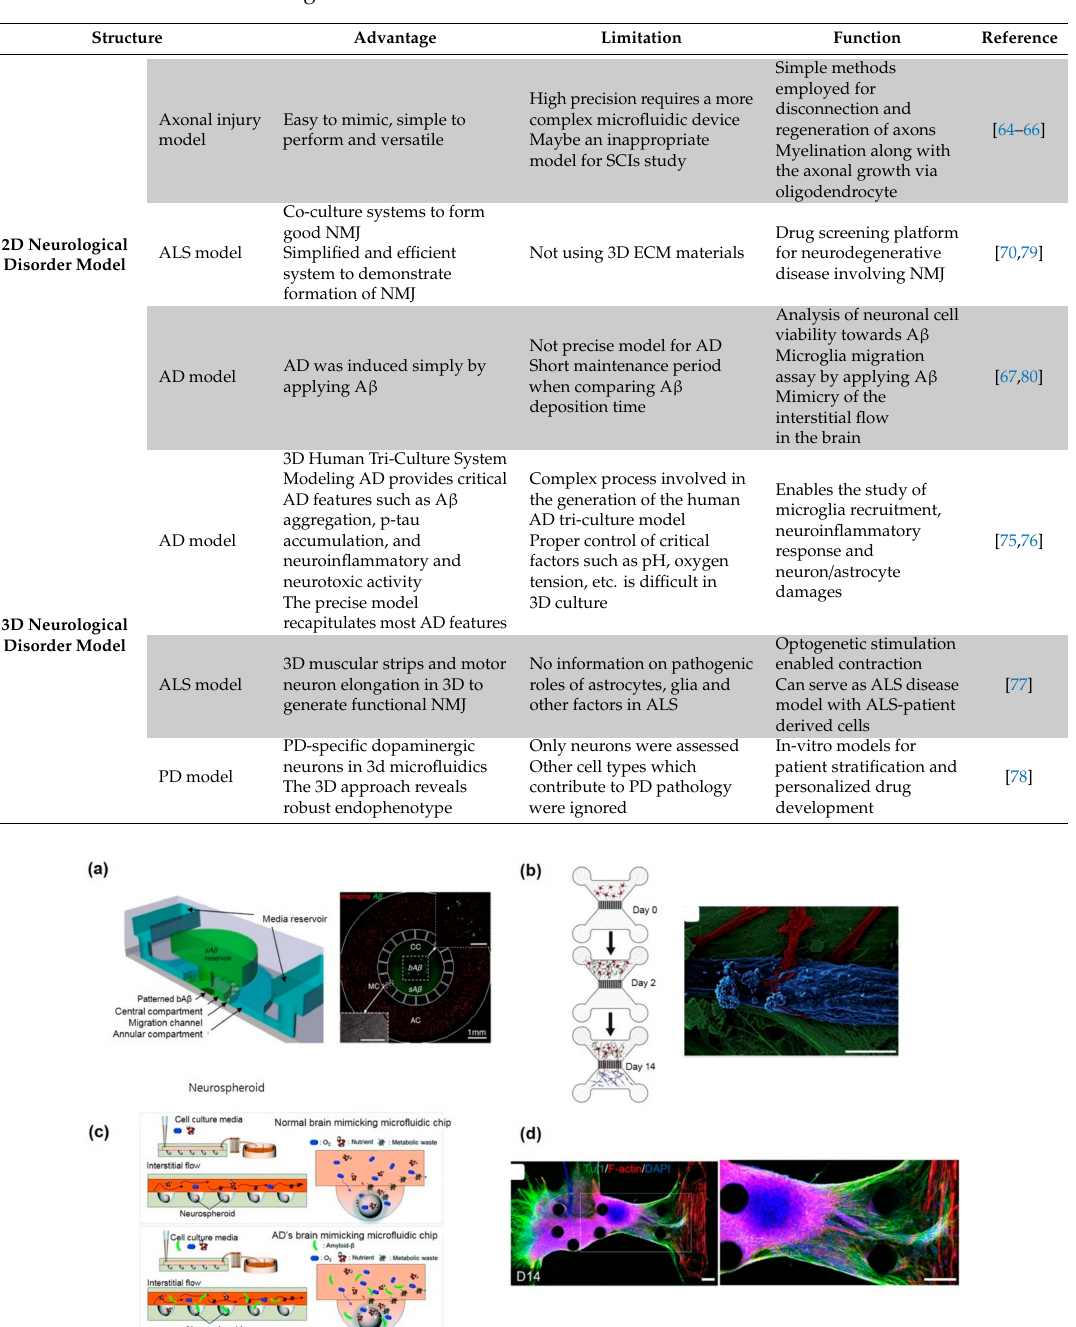
Table 2. Advantages and limitations of current in vitro microfluidic ND models